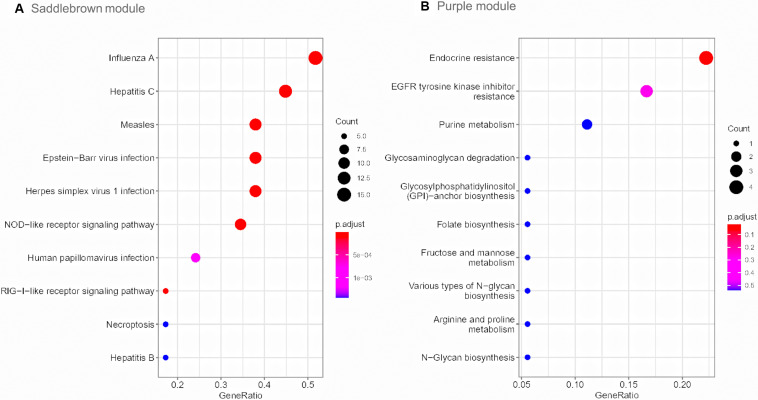
KEGG pathway enrichment analysis. The size of each circle means the amounts of genes. The different color of each circle means the P-value. RichFactor means the number of genes in the key module that belong to this pathway divided by the number of genes in the background gene cluster that belong to this pathway. The top 10 KEGG enrichment pathways of genes in saddlebrown (A) and purple module (B). KEGG, Kyoto Encyclopedia of Genes and Genomes.